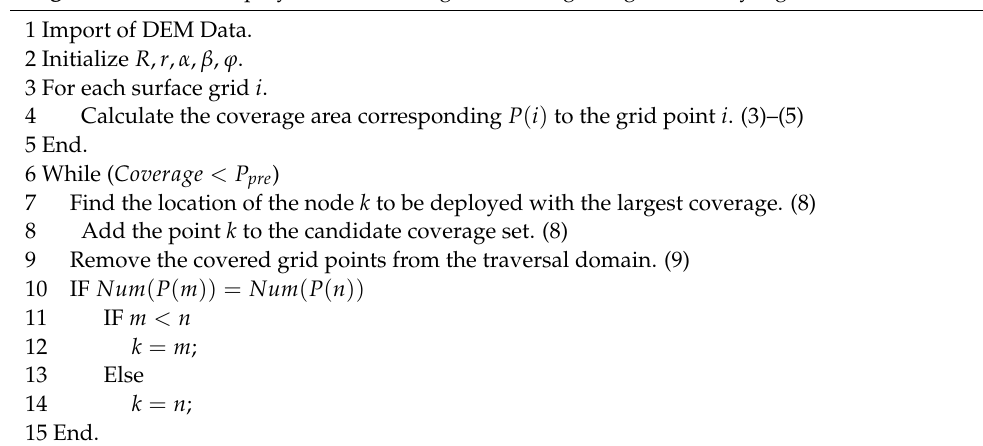
Algorithm 1: WSN deployment based on grid scanning using the Greedy algorithm